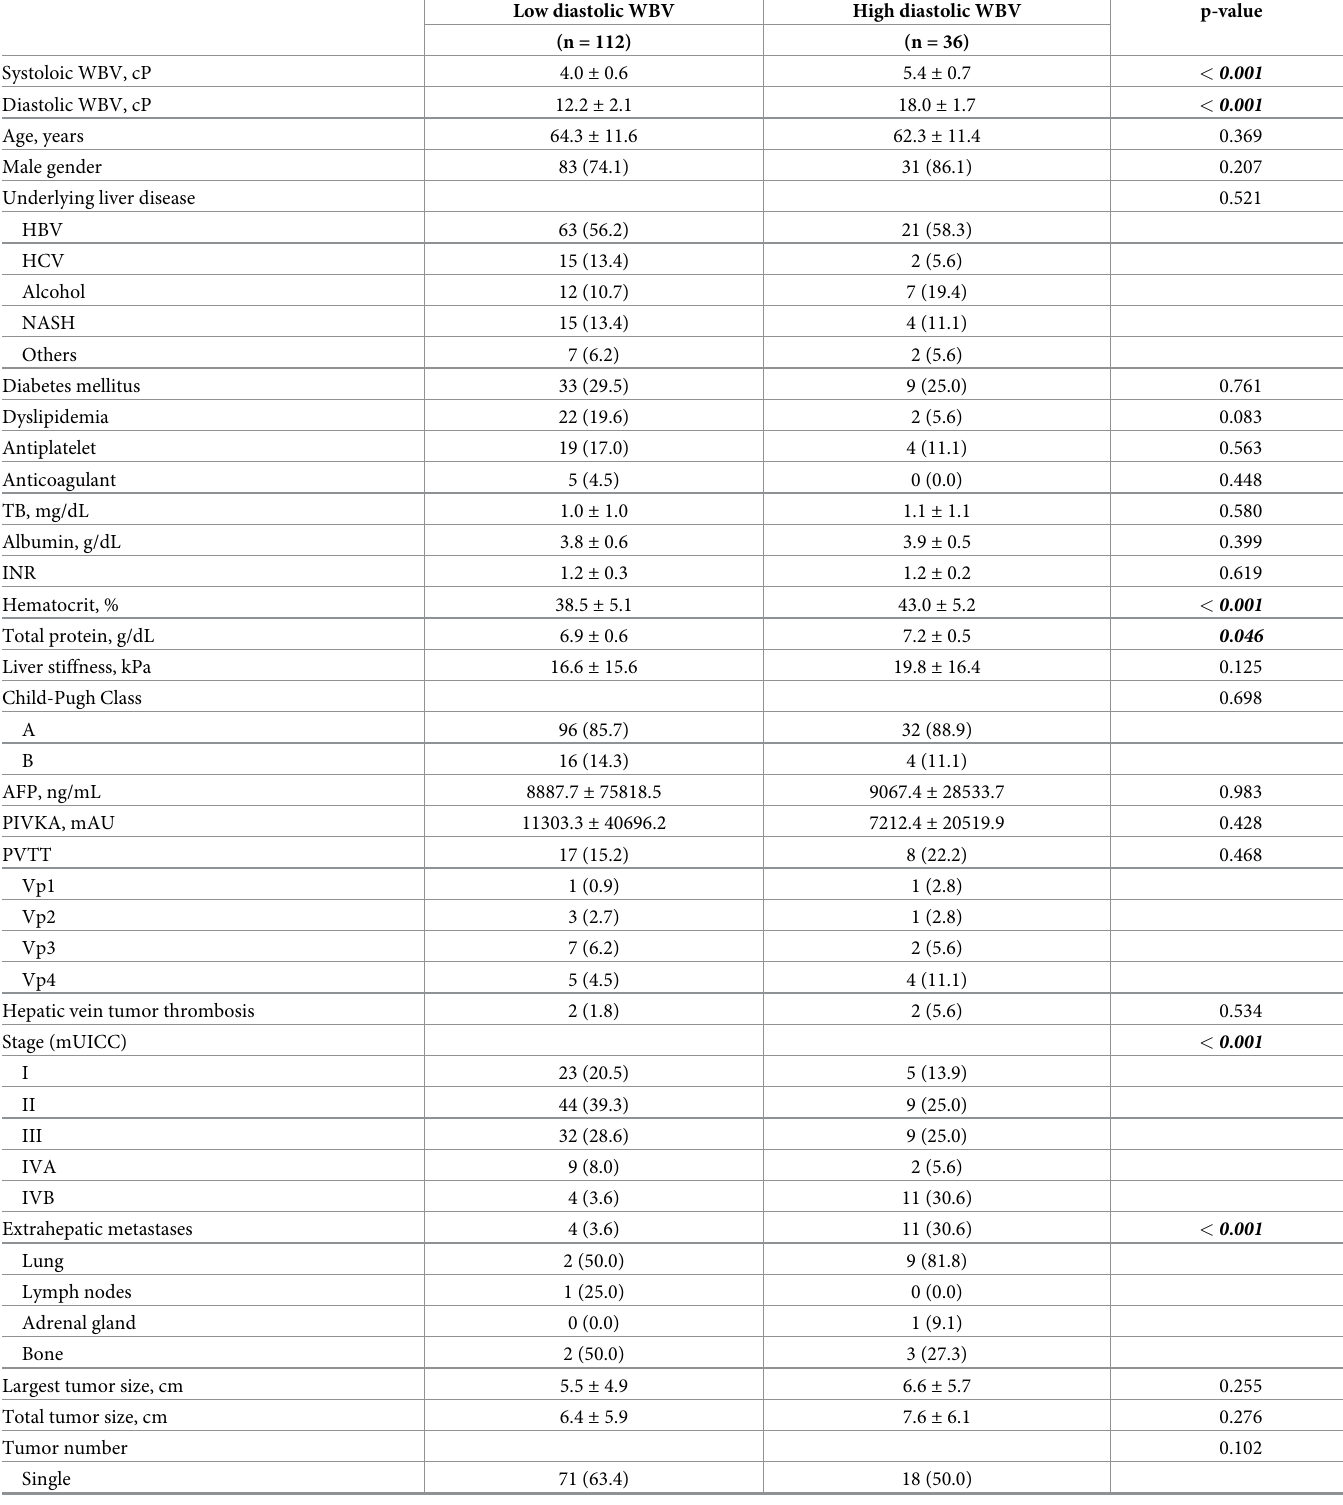
Table 3. Comparison between the patients with high ( > 16.0 cP) diastolic WBV and low diastolic WBV ( ≦ 16.0 cP)